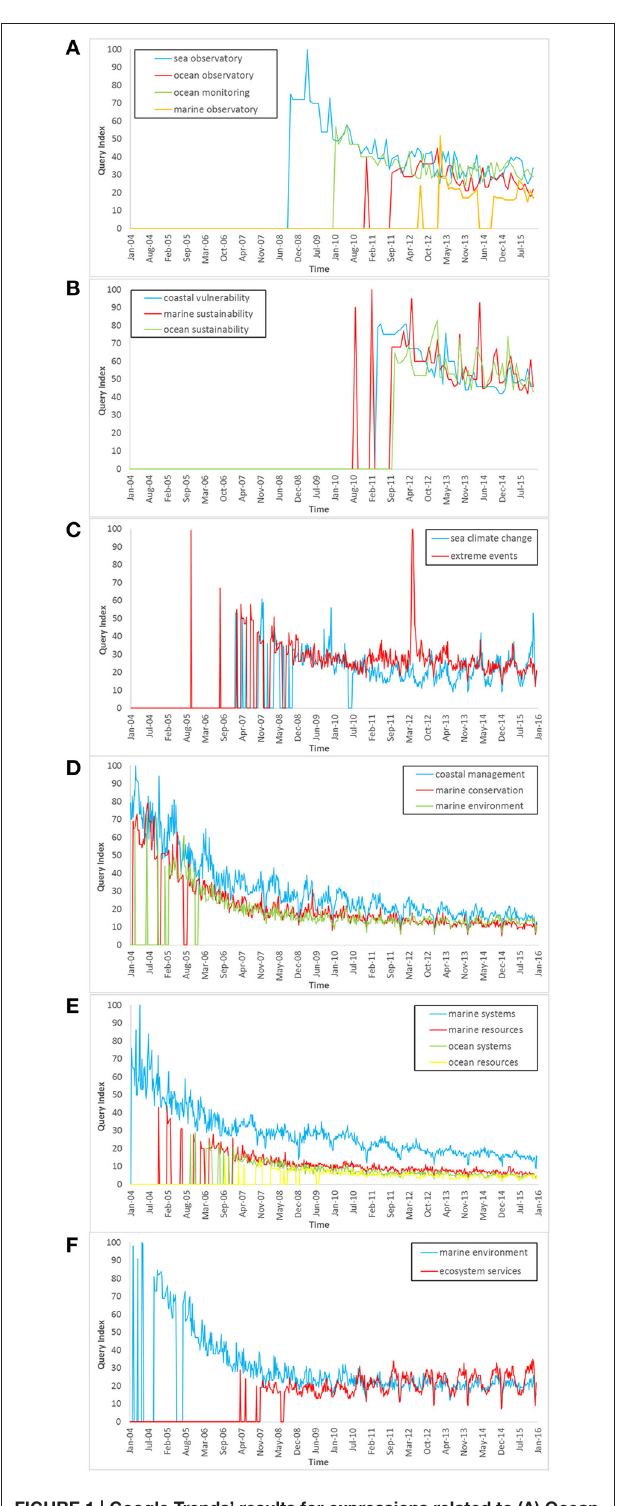
FIGURE 1 | Google Trends’ results for expressions related to (A) Ocean Observatories, (B) vulnerability and sustainability, (C) climate change concerns, (D) management and conservation, (E) marine and ocean systems and resources, and (F) environment and economical aspects; Data source: Google Trends